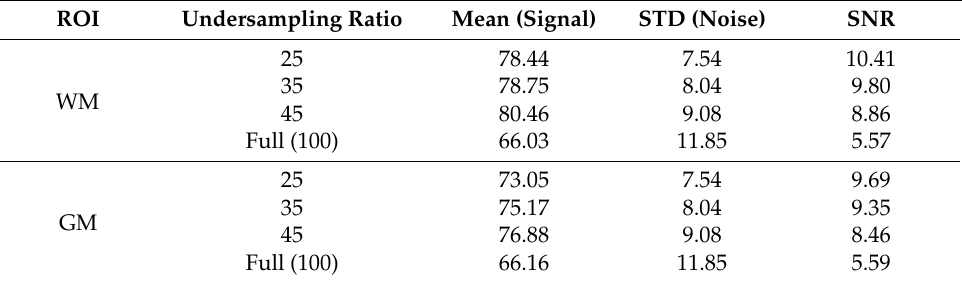
Table 3. SNR depending on the undersampling ratio in gray and white matter regions. ROI Undersampling Ratio Mean (Signal)